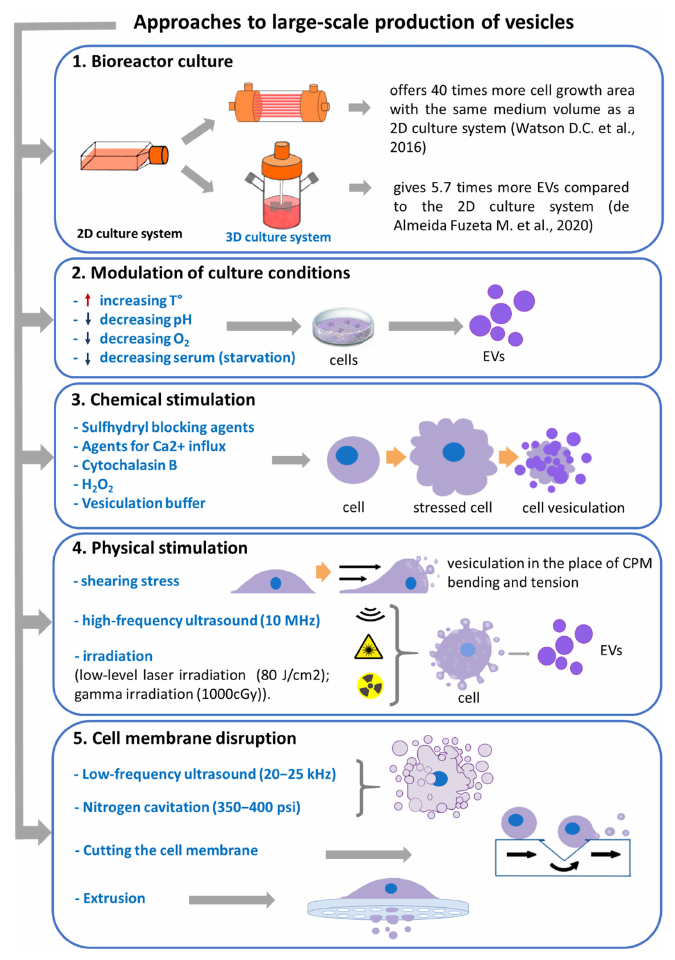
Figure 1. Approaches to the large-scale production of EVs and biomimetic vesicles. CPM—cytoplas- mic membrane.